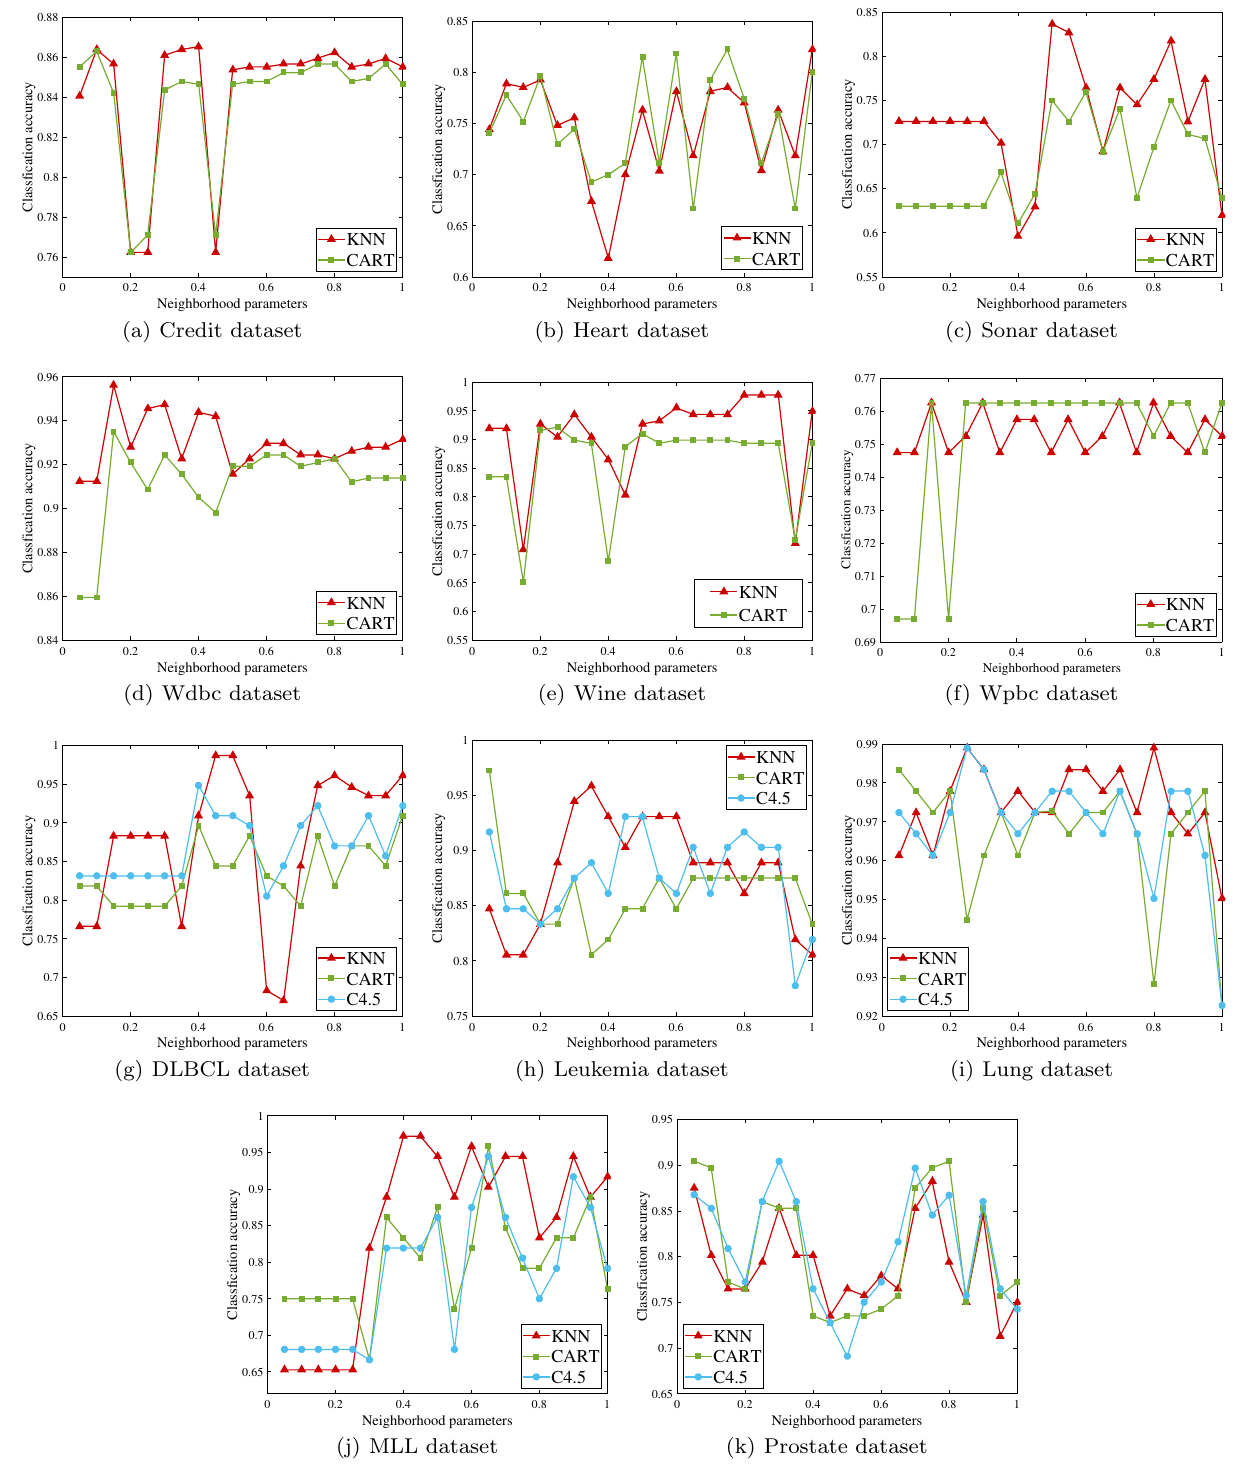
Fig. 3 Classification accuracy for 11 datasets with different neighborhood parameter values KNN, CART, and C4.5, respectively. In Fig. 3h, for the gene dataset Leukemia, when the neighborhood parameter is set to 0.35 under KNN, 0.05 under CART, and 0.45 under C4.5,